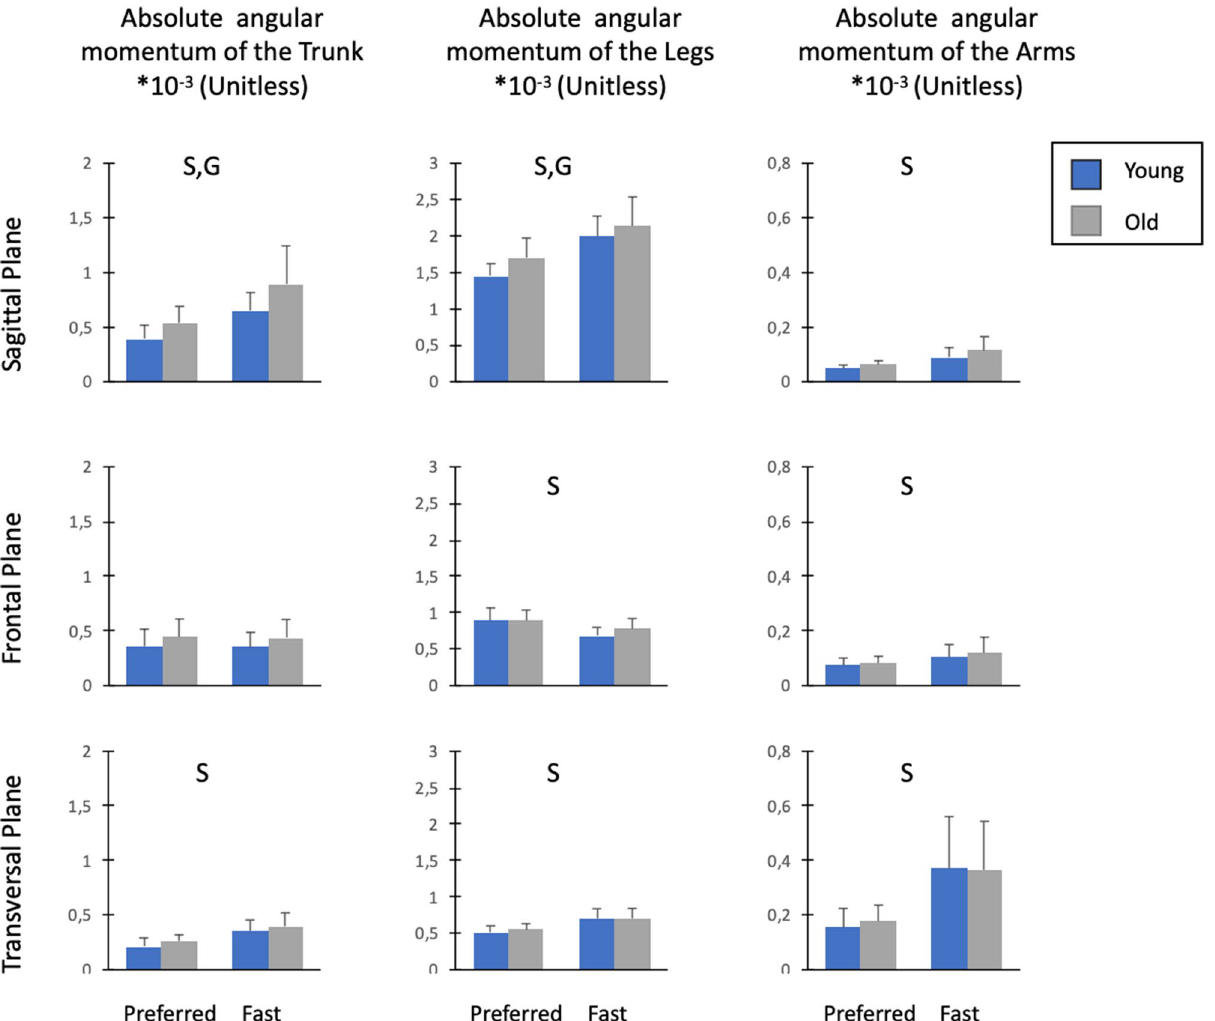
Figure 4. Mean values ± SD of the absolute angular momentum of the trunk, legs and arms in the sagittal, frontal and vertical planes. Absolute angular momentum was averaged over the total duration of the stepping moment and normalized by body mass, body height and (cid:31) g · l ( g = 9.81 m s −2 and l = body height). ‘G’ indicated significant differences between old and young individuals. ‘S’ indicated significant differences between the preferred and fast speed conditions. ‘ G × S ’ indicated significant Group × Speed